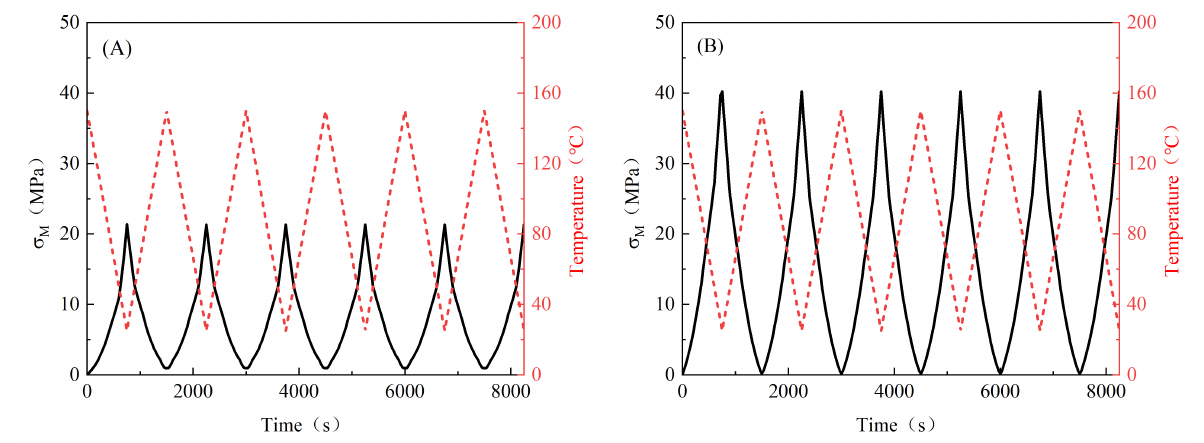
Figure 3. Stress evolution at M-point of model I under the ( A ) fixed constraint and ( B ) non- fixed constraint.